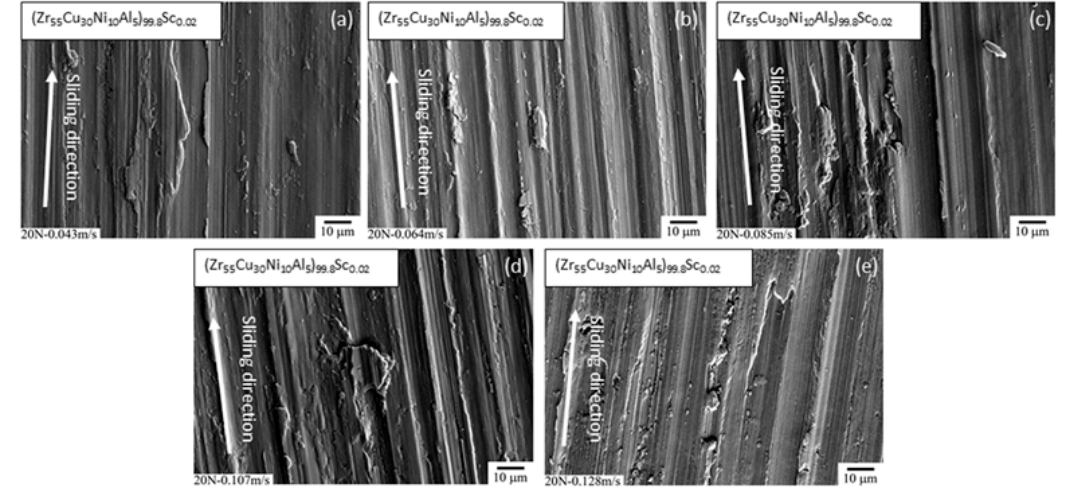
Figure 6. Scanning electron microscopy (SEM) images of a worn surface tested under a 20 N load at sliding velocities of ( a ) 0.043 m/s, ( b ) 0.064 m/s, ( c ) 0.085 m/s, ( d ) 0.107 m/s, and ( e ) 0.128 m/s for the Sc-bearing Zr-based composite BMG.